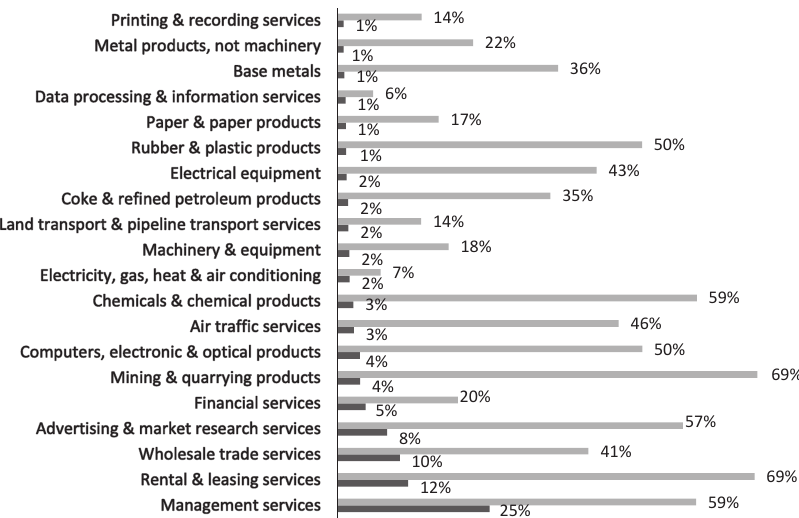
Fig. 6. Retail services dependency on imports for the total supply of direct and indirect inputs into the sector